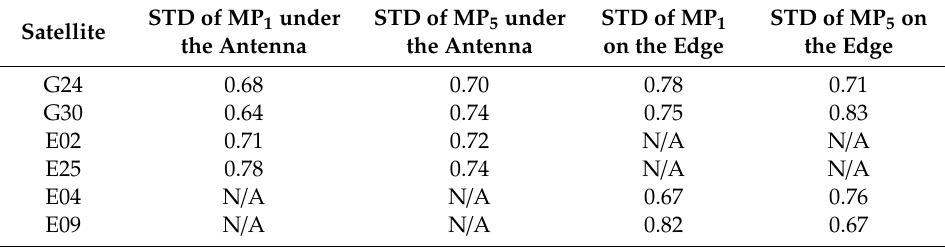
Table 2. STD of MP 1 and MP 5 in two cases.